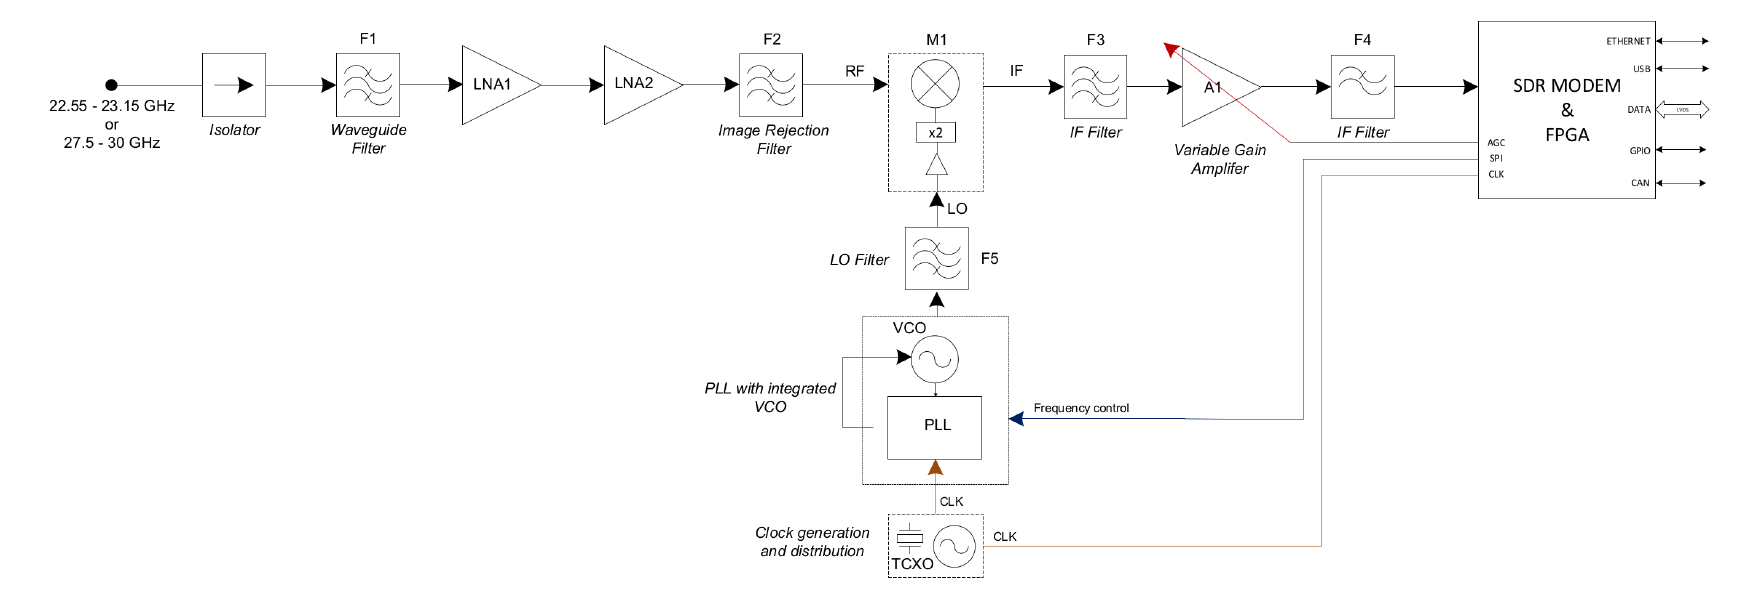
Figure 3. Block diagram. Simplified block diagram of the K/Ka band very-high data rate receiver. In the figure the Low-Noise Amplifier stages are indicated with LNA; F1 is the pre-selection filter; F2 is the image-rejection filter; M1 is the first mixer; VCO is the Voltage Controlled Oscillator that is stabilized by a Phase Locked Loop (PLL). The Reference signal is provided by a Temperature Compensated Crystal Oscillator (TCXO). Radio Frequency (RF) signal, Local Oscillator (LO) signal and Intermediate frequency (IF) signal identify the down-conversion mixer